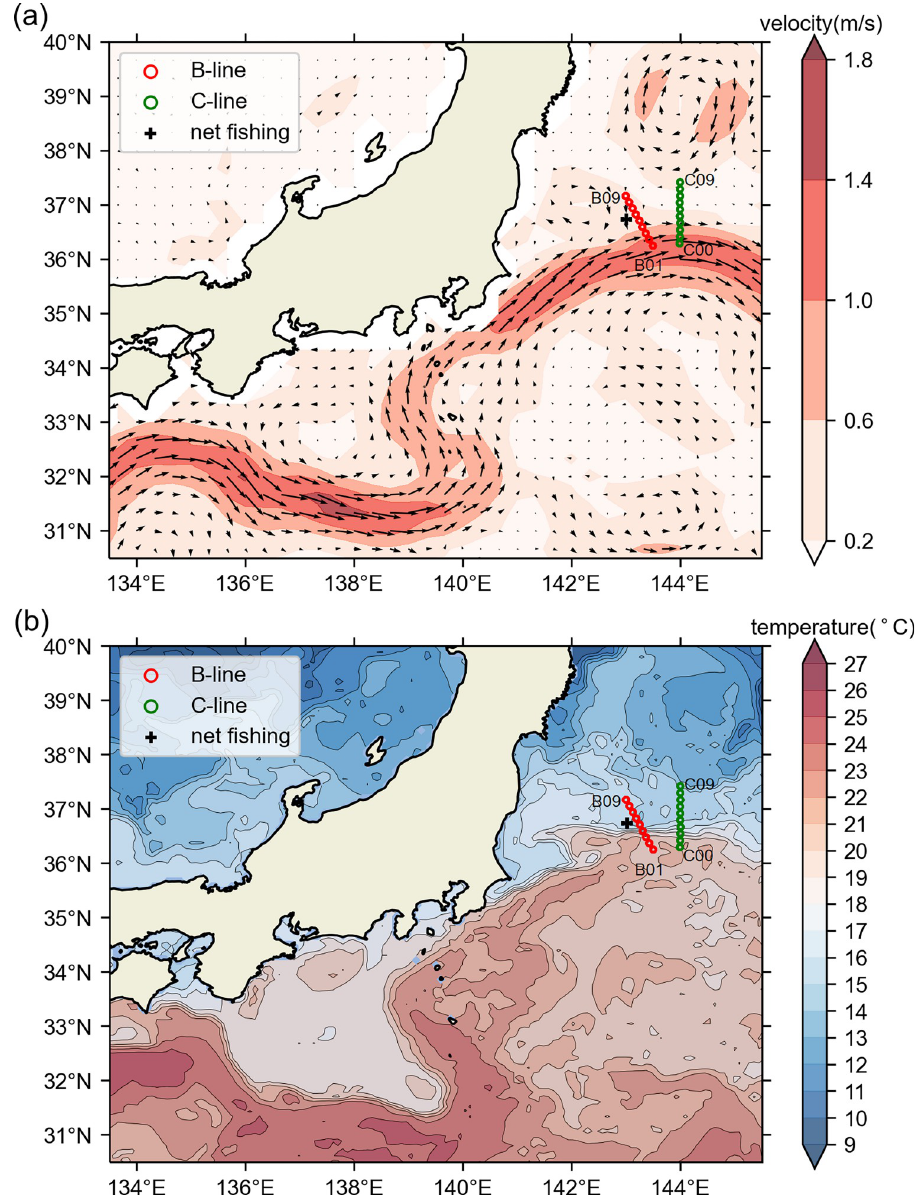
Fig 1. Positions of OceanDNA sampling stations in the Kuroshio Extension area. The red circles represent stations B01–B09, the green circles represent stations C00–C09, and the plus mark represents the net sampling location. Maps were made in Spyder (Python 3.7) using Natural Earth data. Free vector and raster map data @ naturalearthdata.com. (a) Colors represent current speeds and arrows represent current velocity vectors on the sea surface (5-day mean from May 10 to 14, 2018) from Ocean Surface Current Analysis Real-time data [34] (https://podaac.jpl.nasa.gov/Data hosted and openly shared by the PO.DAAC, without restriction, in accordance with NASA’s Earth Science program Data and Information Policy). (b) The contours and colors represent sea surface temperature (˚C) distribution on May 10, 2018, from GHRSST Level 4 OSTIA Global Foundation Sea Surface Temperature Analysis data [35] (hosted and openly shared by the PO.DAAC, without restriction, in accordance with NASA’s Earth Science program Data and Information Policy).